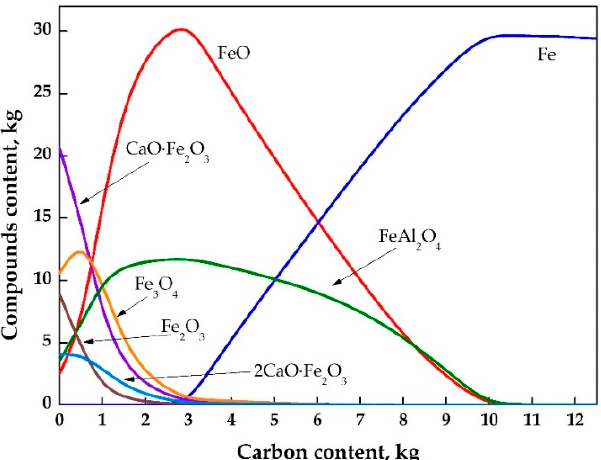
Figure 6. The equilibrium compositions of iron-containing phases as a function of the added carbon in the system at 1600 °C.